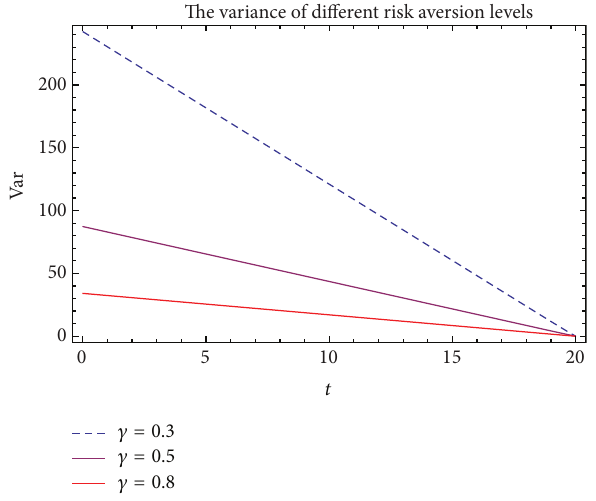
Figure 6: Variance with different risk aversion levels 𝛾